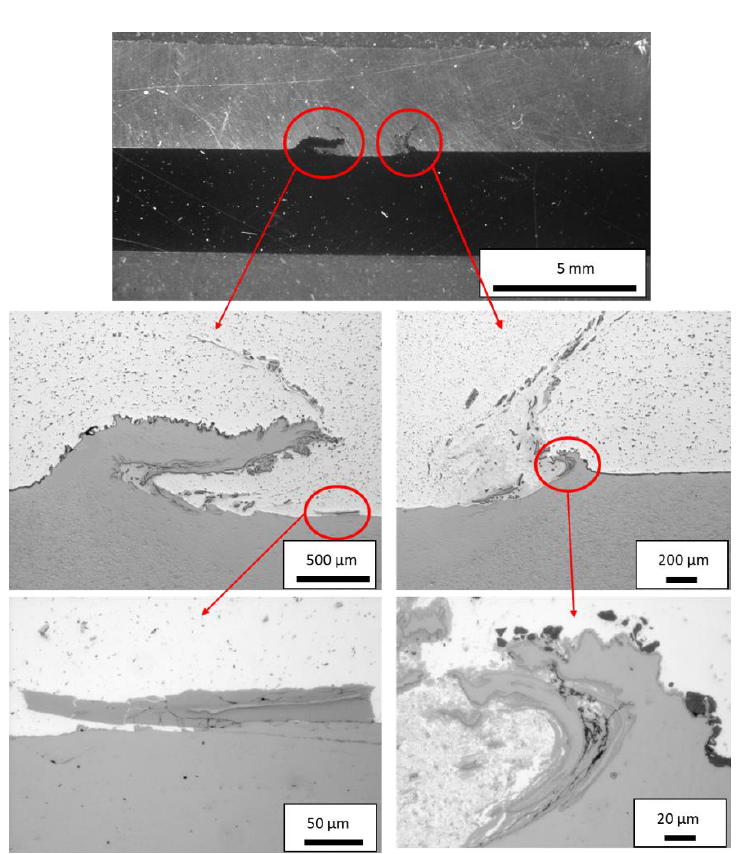
Figure 7. Sample 987 macro- and micro-section.